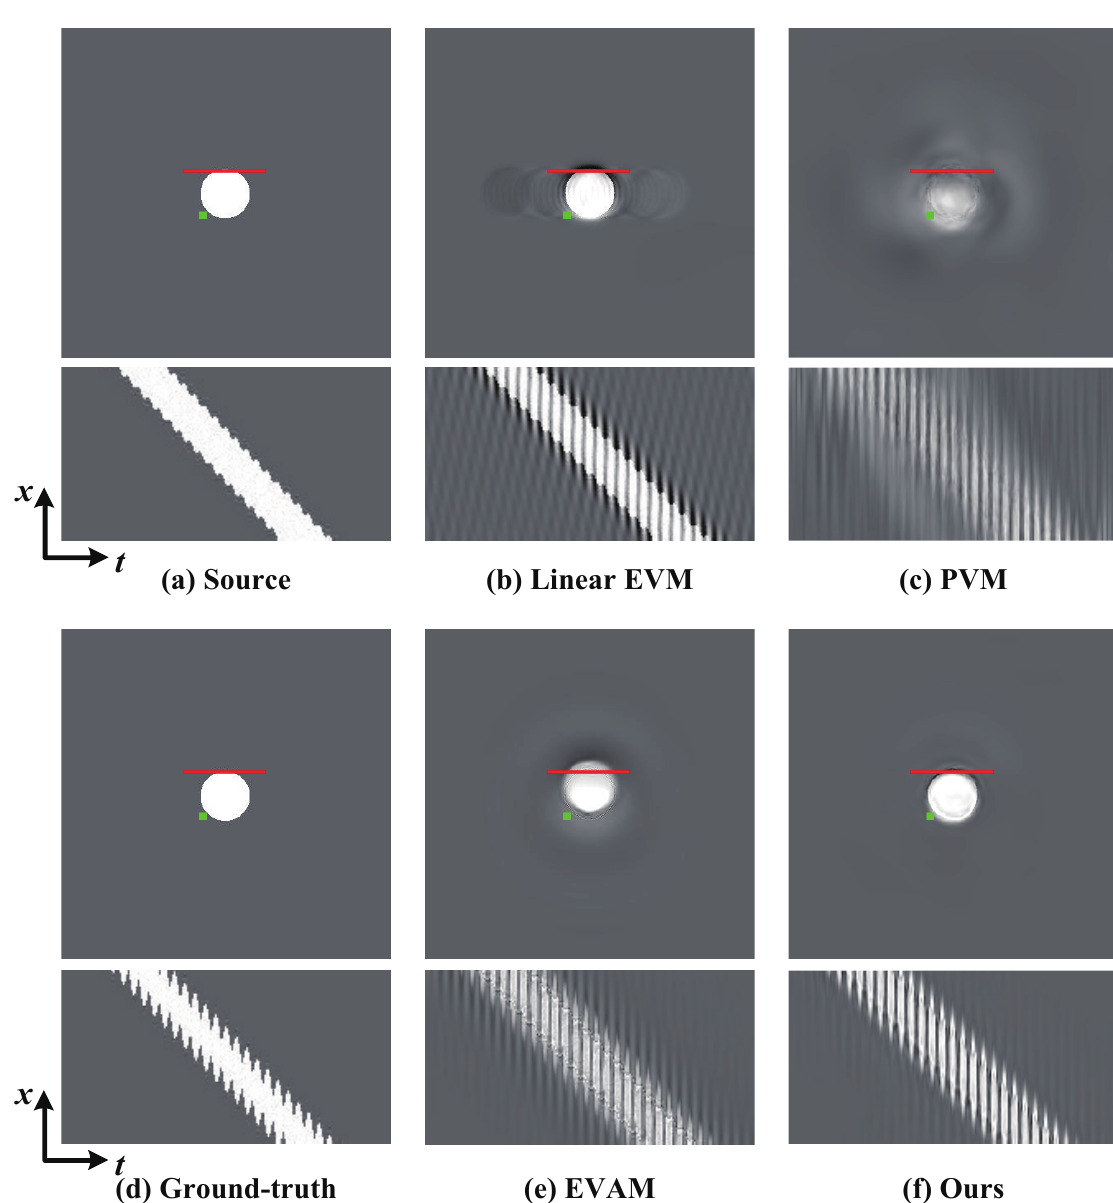
Figure 6. Ground-truth compared with magnification results of our algorithm and other techniques. ( a ) A frame from SynVideo1, where we create a tiny vibration in the vertical direction when the white circle moves from left to right. ( b – c ) Linear EVM [6] and phase-based motion magnification [12]. ( d ) The ground-truth by 20 times magnification. ( e ) Motion acceleration magnification [17]. ( f ) Our proposed algorithm. Motion magnification using different magnification techniques can be observed by spatio-temporal slices at the red line. Compared against other techniques, our algorithm reveals the small motion and does not generate blurring